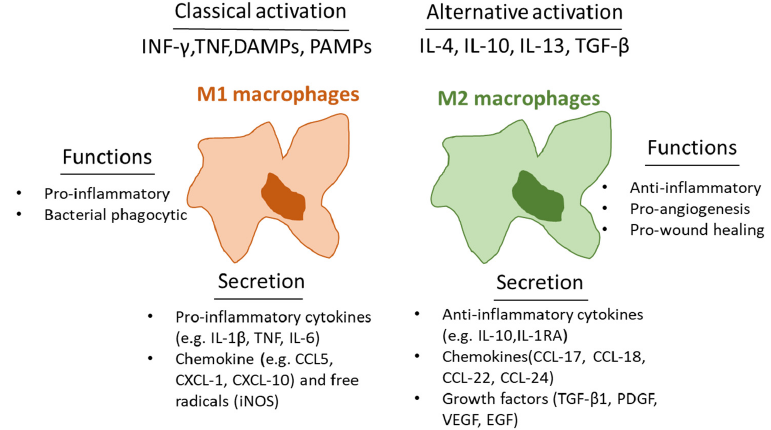
Figure 1. M1 and M2 polarization of macrophages. M1 macrophages produce pro ‐ inflammatory cytokines, mediate resistance to pathogens, and possess strong microbicidal properties. M2 macrophages, on the other hand, are anti ‐ inflammatory macrophages that mediate inflammation resolu ‐ tion and contribute to wound healing by promoting angiogenesis.